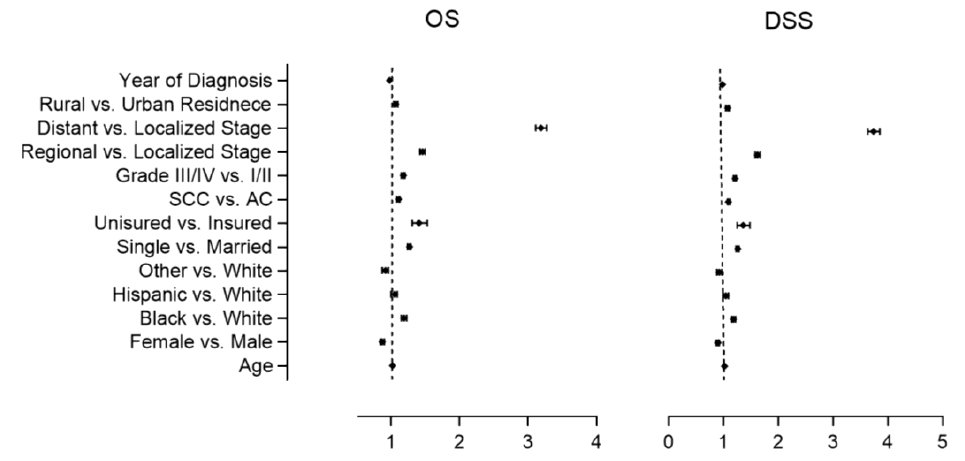
Figure 2. Multivariable OS and DSS forest plots with 95% CI for sociodemographic and clinicopatho- logical variables available in the SEER database are shown. All variables collected from the SEER database were used as covariates in multivariate model. Table 4. Descriptive characteristics of the quality-of-care variables in the NCDB cohort .